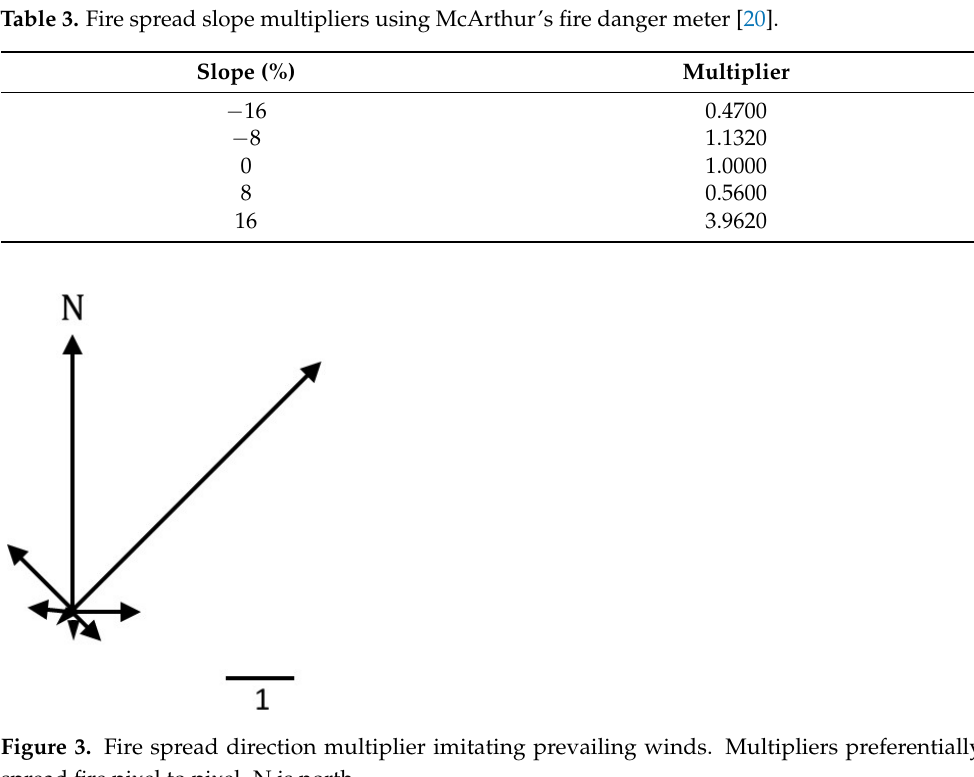
Table 3. Fire spread slope multipliers using McArthur’s fire danger meter [20]. Slope (%)